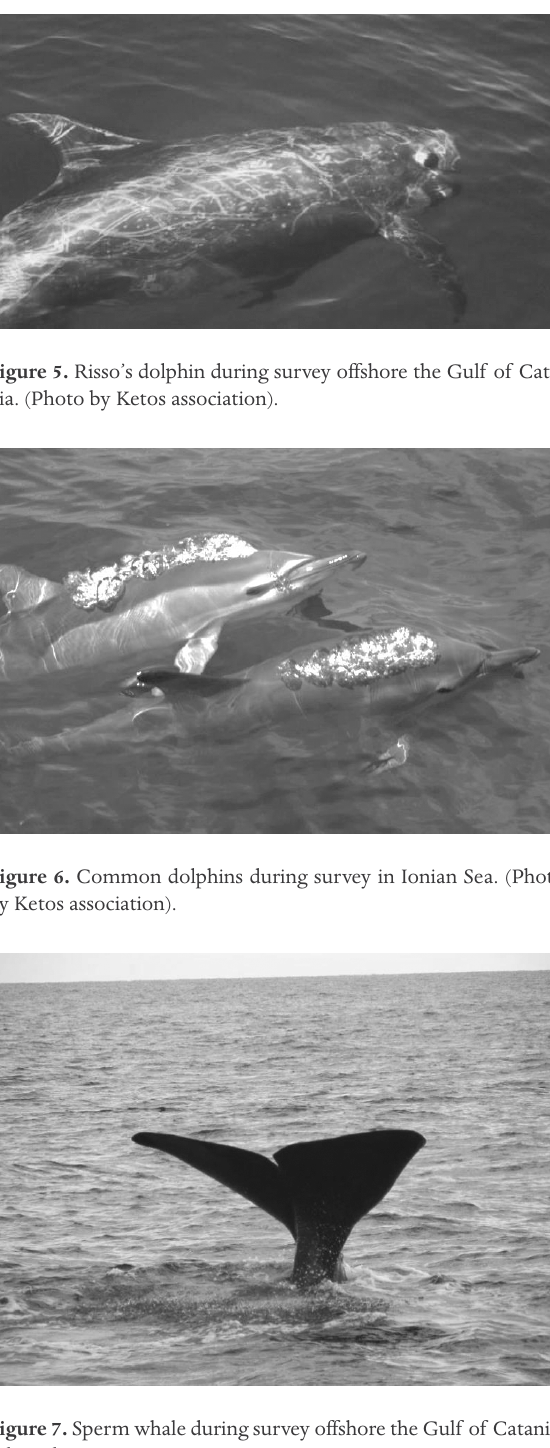
Figure 7. Sperm whale during survey offshore the Gulf of Catania. (Photo by Ketos